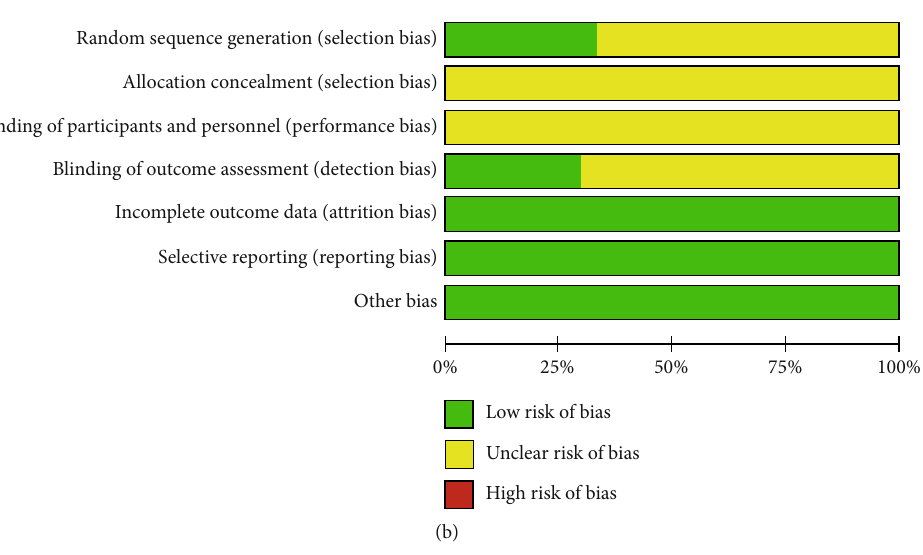
Figure 2: (a) Aggregate Risk of bias graph for each experimental animal studies; “ ? ” : Unclear risk; “ + ” : Low risk. (b) Risk of bias